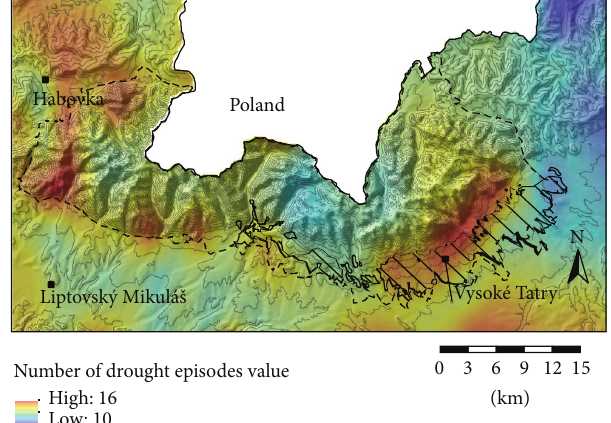
Figure 4: Number of all drought situations according to the 12- month SPI. Red color represents higher frequency of drought sit- uations. Dashed line represents border of the National Park. Square represents city or settlement. Area with left-hatching represents calamity in